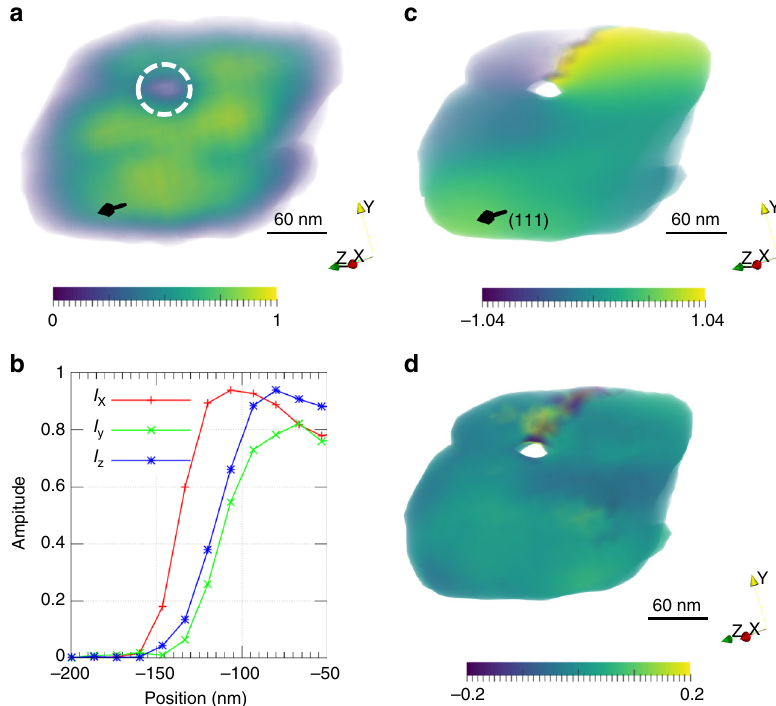
Fig. 3 Reconstructed amplitude and strain in a Cu grain. a Reconstructed electron density showing a cylindrical region of low amplitude circled in white. Color is by amplitude. b Amplitude variation across the surface of the grain. c , d Volume renderings of displacement and strain in the grain projected along the (111) direction. c is colored by projected displacement in Å along the (111) direction while d is colored by the strain projected along the (111)